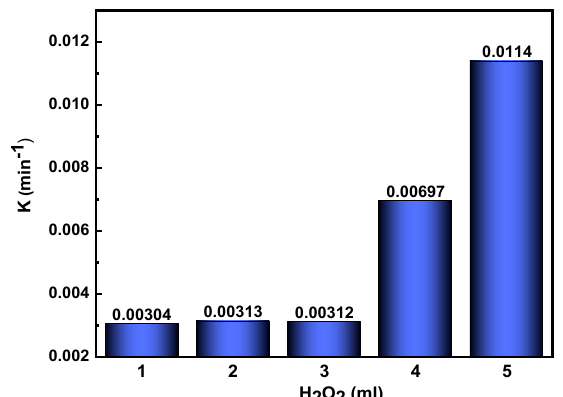
Figure 7. The k versus H 2 O 2 concentration of MB dye by 0.1 g of 7.5% Nd 2 O 3 doped CuO NPs under visible irradiation.